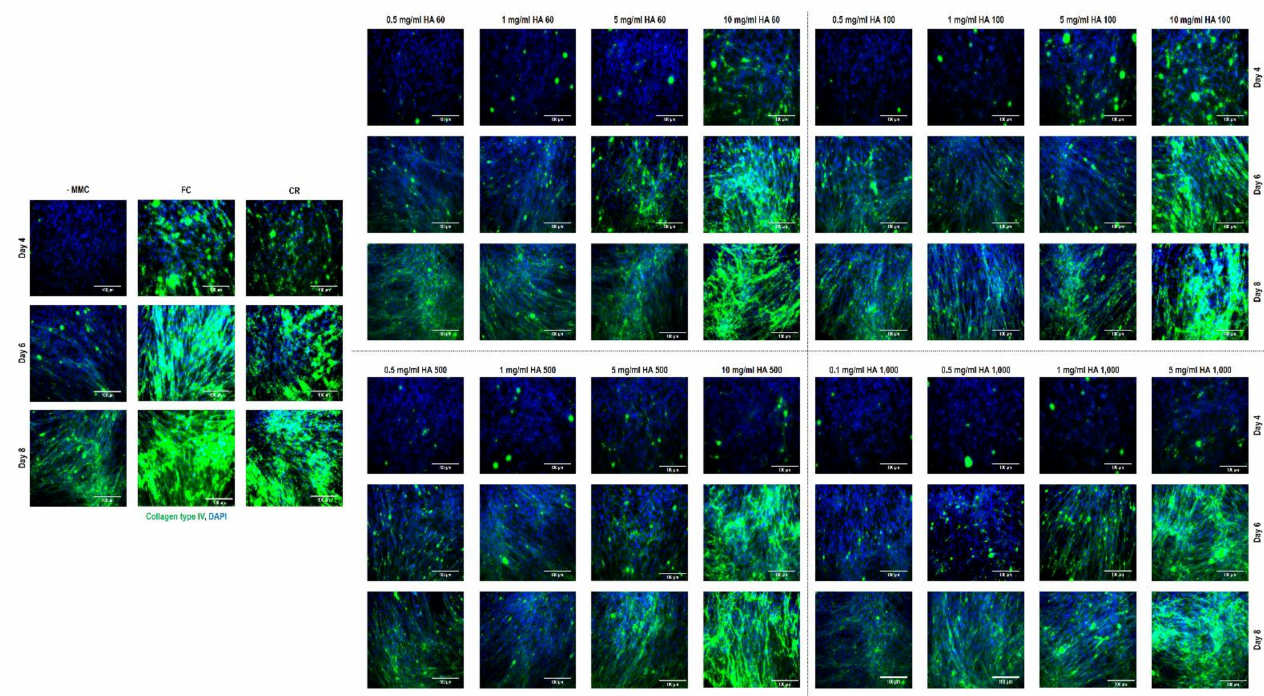
Figure 3. Immunocytochemistry analysis revealed that Ficoll ® induced the highest collagen type III deposition at all timepoints and at day 8 (longest timepoint assessed), the carrageenan, the 10 mg/mL HA 60 kDa, the 10 mg/mL HA 100 kDa, the 5 and 10 mg/mL HA 500 kDa and the 5 mg/mL HA 1000 kDa induced significantly higher collagen type III deposition than the non-MMC group.